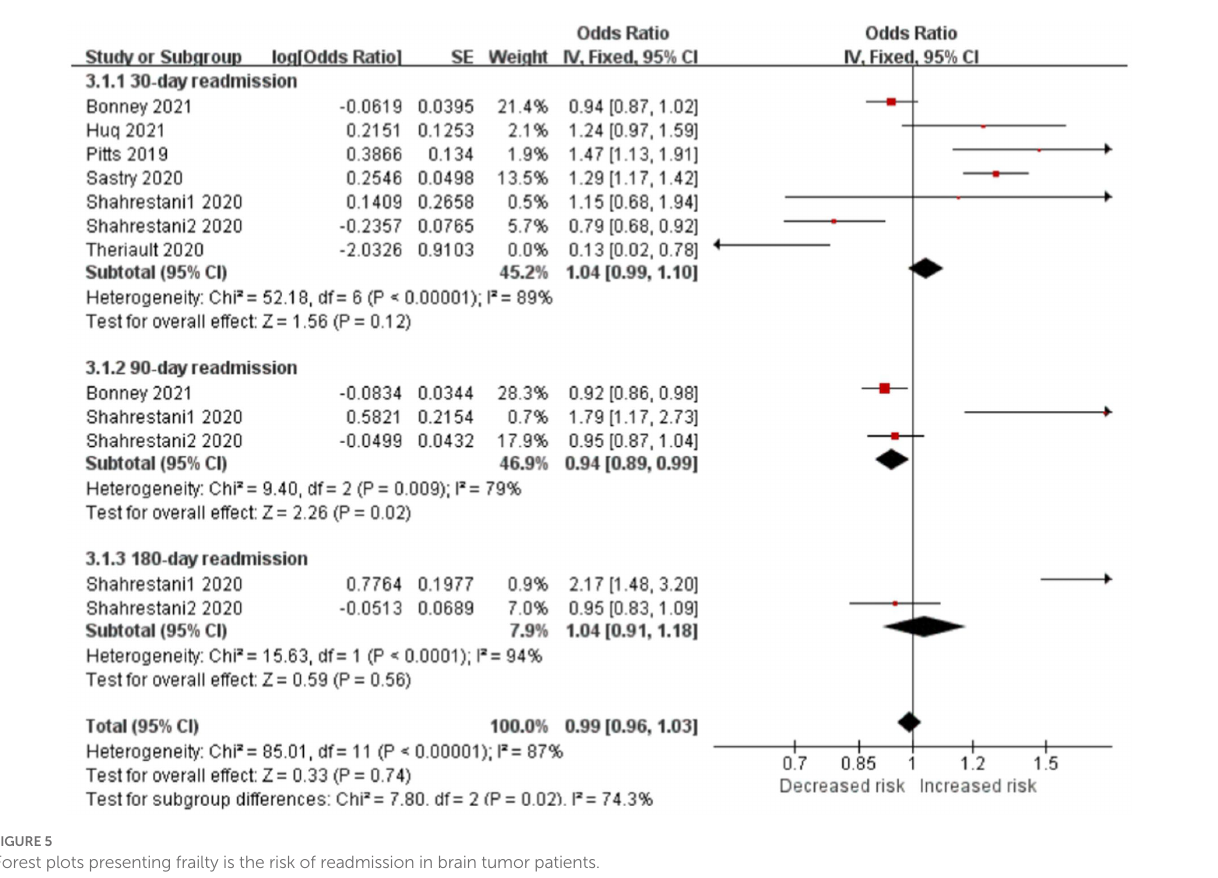
FIGURE 5 Forest plots presenting frailty is the risk of readmission in brain tumor patients.